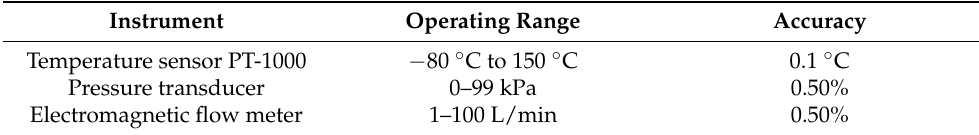
Table 3. Parameters of the measuring